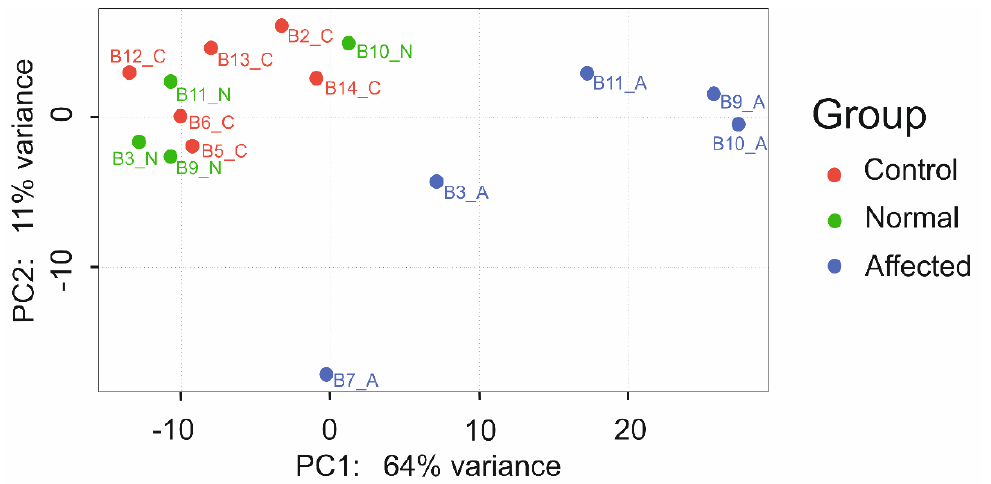
Figure 4. Principal component analysis (PCA) of samples demonstrating clustering based on expres- sion profiles plotted against the two most variable components (PC1 and PC2). Samples from control animals (red) and normal skin from affected animals (green) cluster together, whereas samples from alopecic skin from affected animals (blue) are clearly separated from the clusters representing normal skin but show a higher inter-group variability.